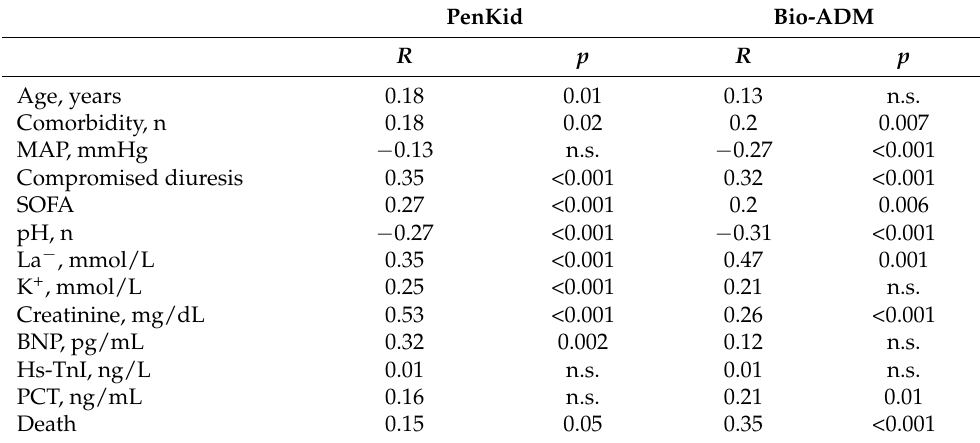
Table 3. Pearson analysis for PenKid and Bio-ADM.